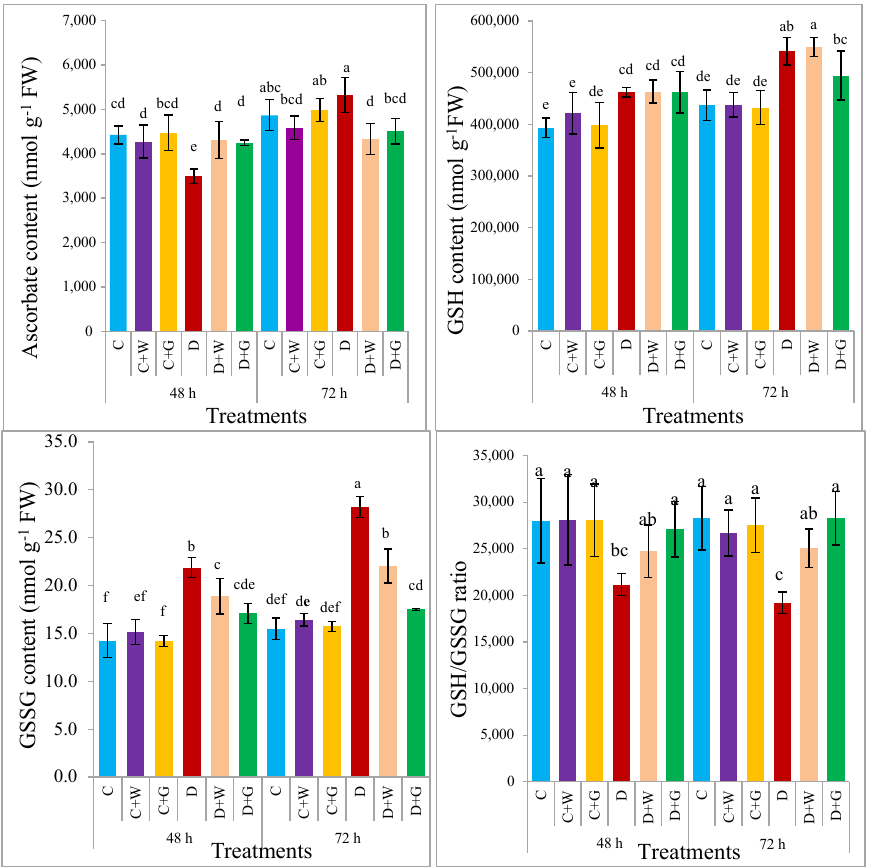
Fig. 4 Effect of drought stress and exogenous GA on ascorbate-glutathione pool in wheat seedlings. Codes are as for Fig.